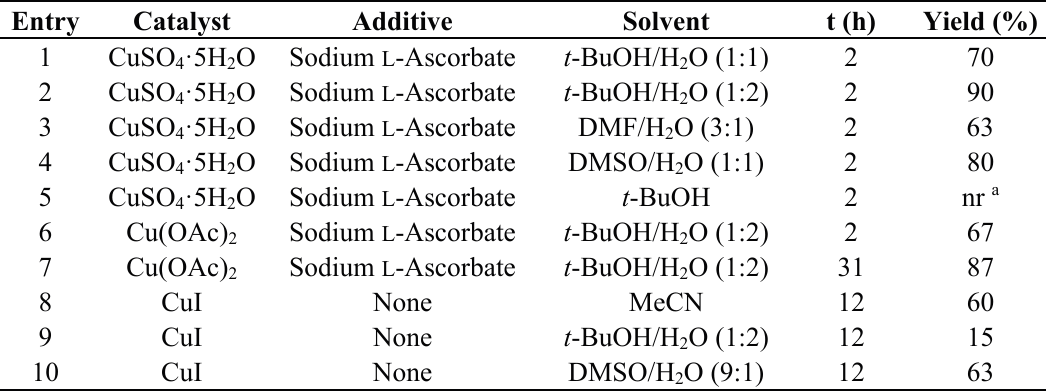
Table 1. Screening of the reaction condition for the CuAAC reaction between 4 β -azido-podophyllotoxin ( 18 ) and the glycosylated terminal alkyne ( 12a